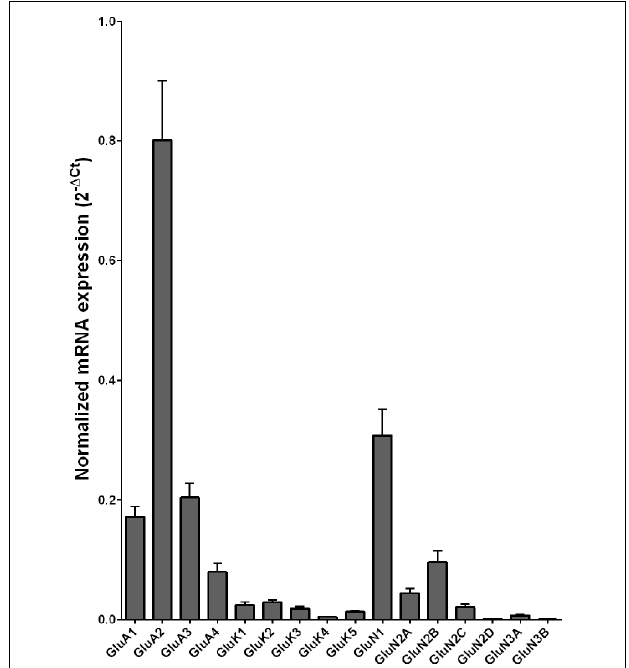
FIGURE 5 | Expression of ionotropic glutamate receptor subunit mRNAs in the prefrontal cortex of controls ( n = 15). The mRNA level of each subunit was normalized to reference genes ACTB and RPLP0 and presented as mean ±